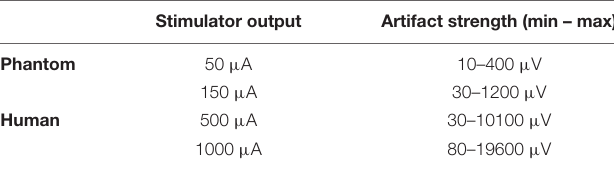
TABLE 4 | Comparison of the tACS intensities, as set in the stimulator (left column), and artifact strengths as measured in the EEG signal (right column) between the phantom and the human